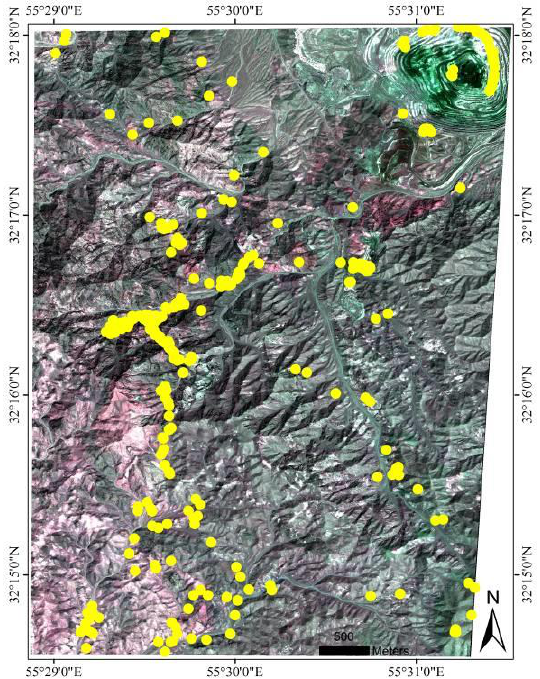
Fig. 7. Field sampling points of the Chadormalu area, central Iran mapped on 2 m spatial resolution false color composite image of WV-3. Red, green and blue color represent band 5, band 2 and band 3 respectively with the aim of revealing ferric iron and desert varnish in magenta hue which are mostly matched with Zarigan granite